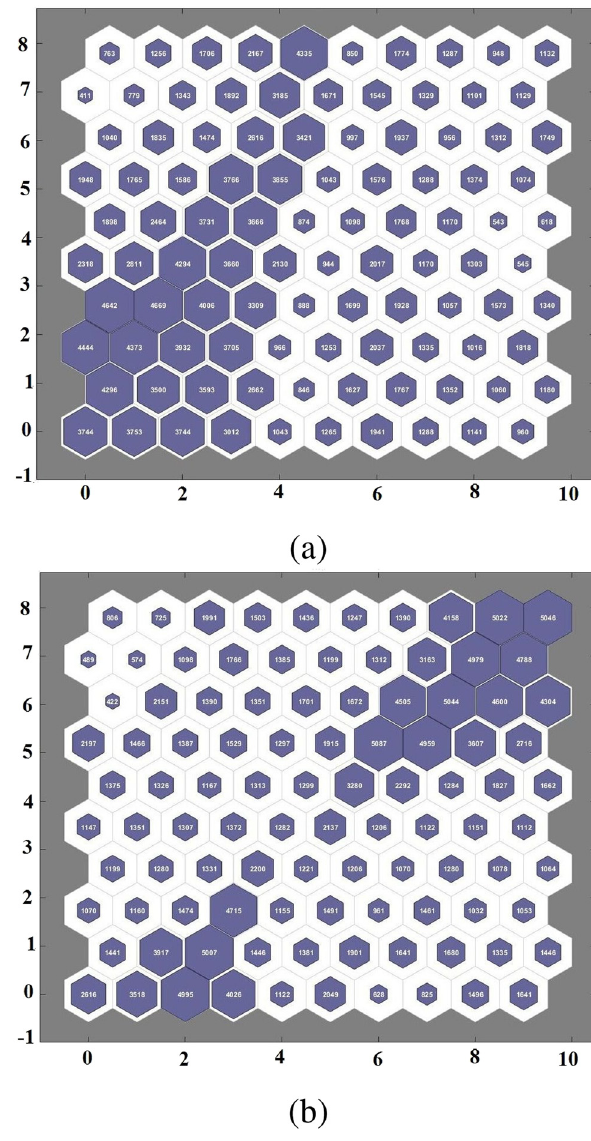
Figure 4: Clustering of weights centres: ( a ) sample hits 1 and ( b ) sample hits